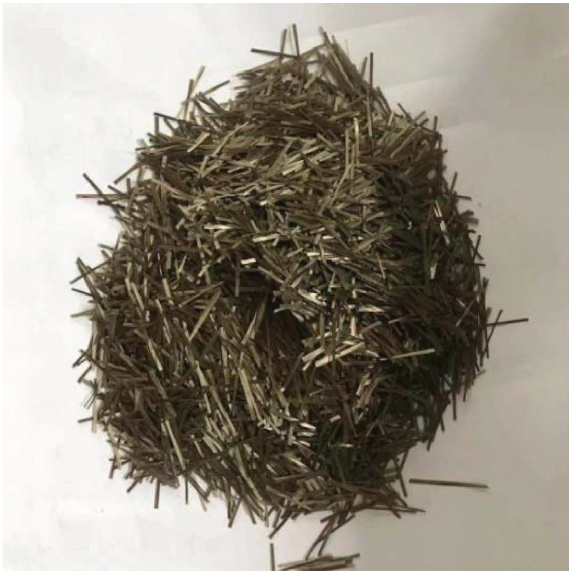
Figure 1: Chopped basalt fber.